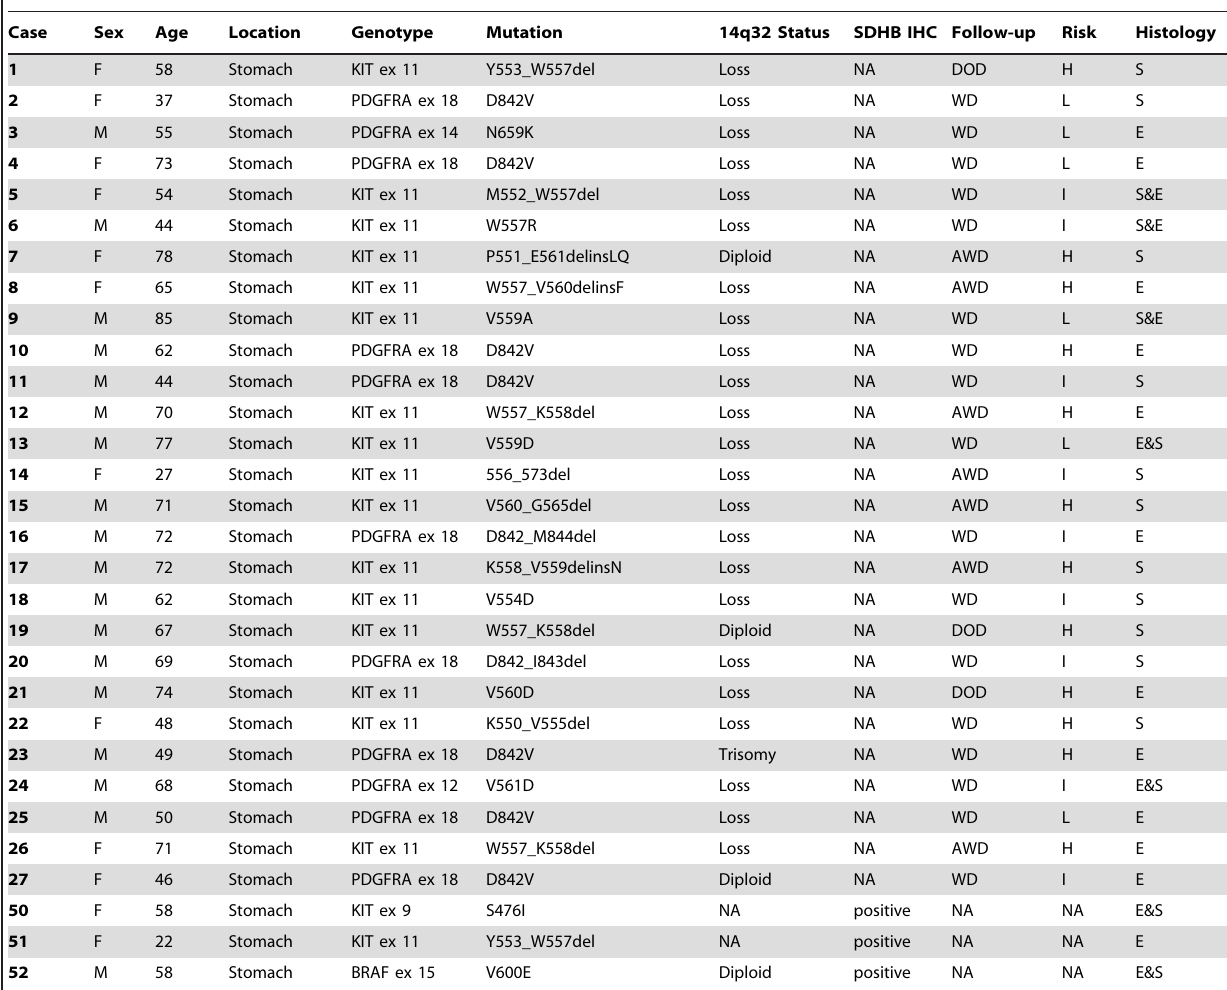
Table 1. Adult Mutant GIST case